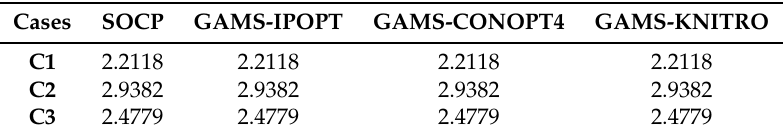
Table 5. Numerical results for the λ -coefficient for all the simulation cases in the 69-nodes test feeder. Cases